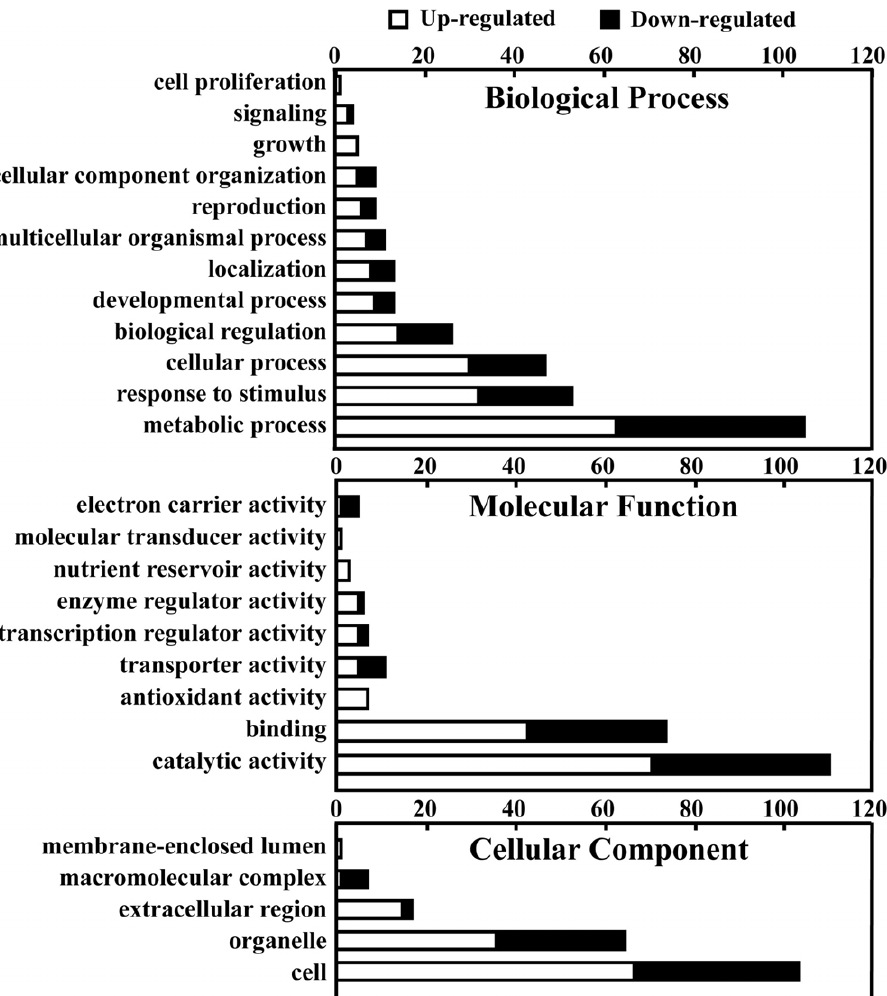
Figure 4. Functional categorization of the common upregulated and downregulated genes in ‘Meiwa’ and ‘Newhall’ based on the GO annotation.